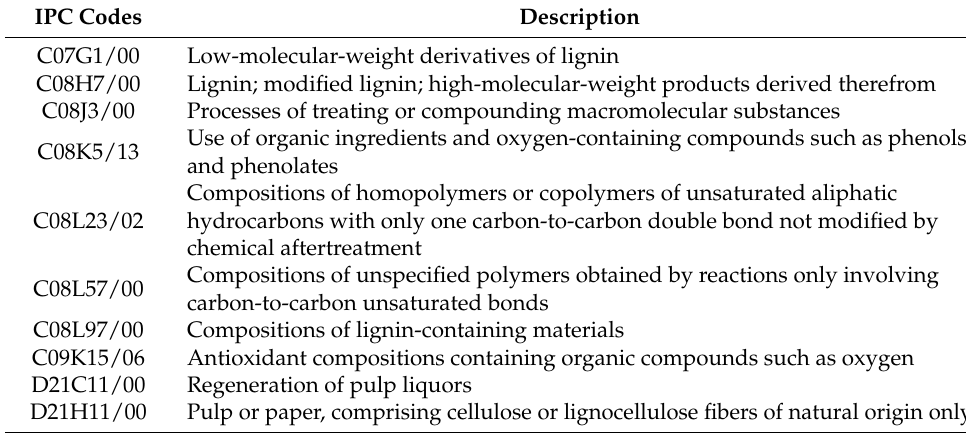
Table 1. Relevant classifications of the US9347177B2 patent